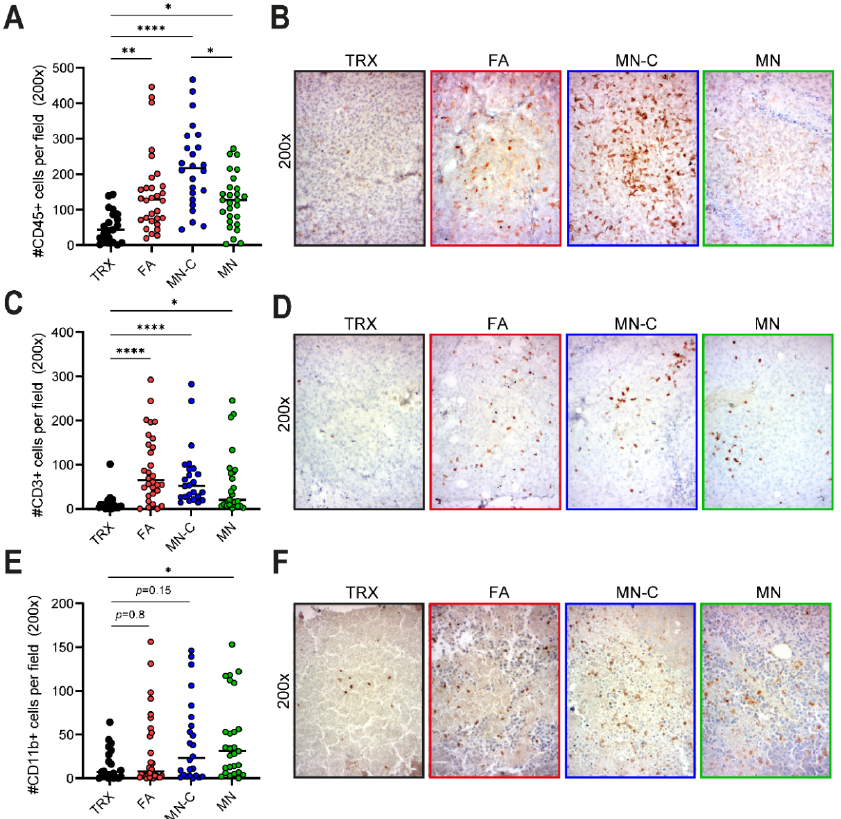
Figure 4. Immune cell infiltration in B16F10 melanoma after vaccination. ( A ) CD45+ immune cells present in B16F10 tumors derived from Study II as determined by IHC. Each dot represents one microscopic field. ( B ) Representative images of CD45 staining for each group at 200 × magnification. ( C ) CD3+ immune cells present in B16F10 tumors derived from Study II as determined by IHC. Each dot represents one microscopic field. ( D ) Representative images of CD3 staining for each group at 200 × magnification. ( E ) CD11b+ immune cells present in B16F10 tumors derived from Study II as determined by IHC. Each dot represents one microscopic field. ( F ) Representative images of CD11b staining for each group at 200 × magnification. * p < 0.05, ** p < 0.01, and **** p <